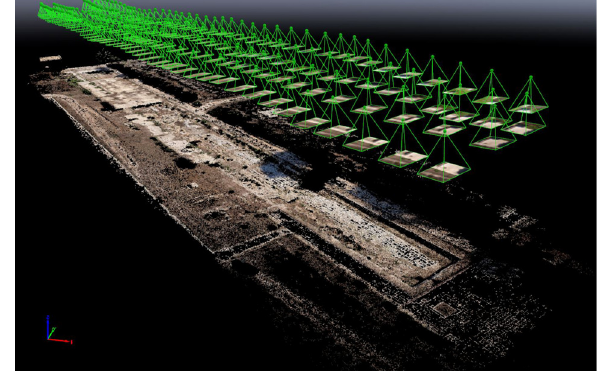
Figure 10. Camera position of the Decumanus maximus flight.